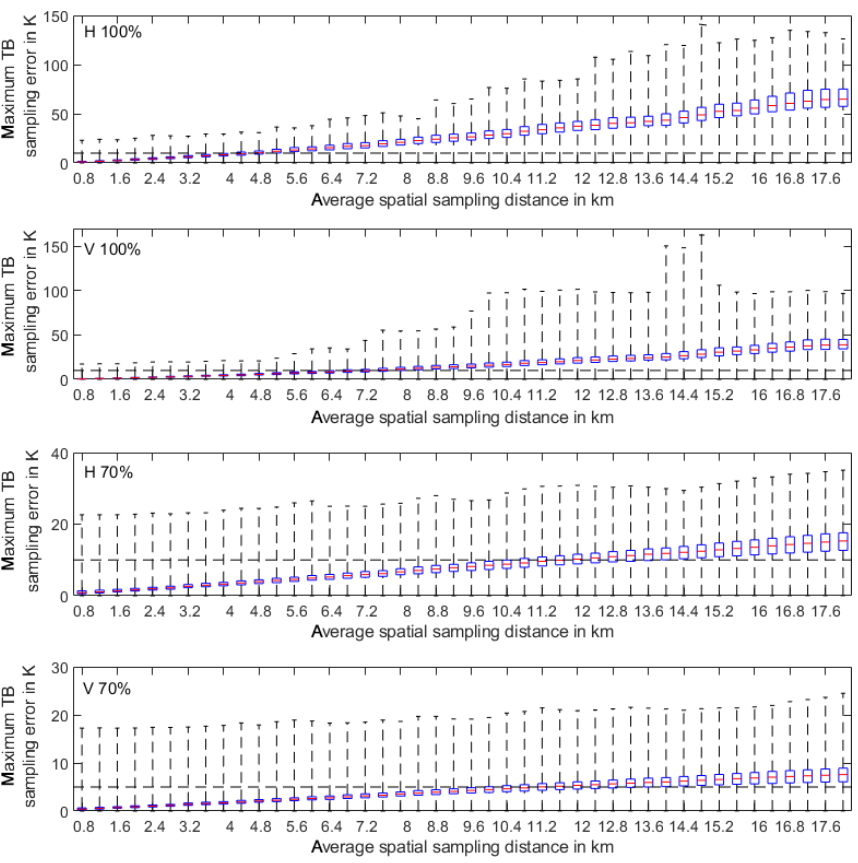
Figure 6. Same as Fig. 3 but for the sampling error of the brightness temperature. The respective brightness temperature errors are (equivalent to a soil moisture accuracy of 0.04cm 3 cm − 3 ) 10K for H polarization and 5K for V polarization and are indicated as dashed horizontal